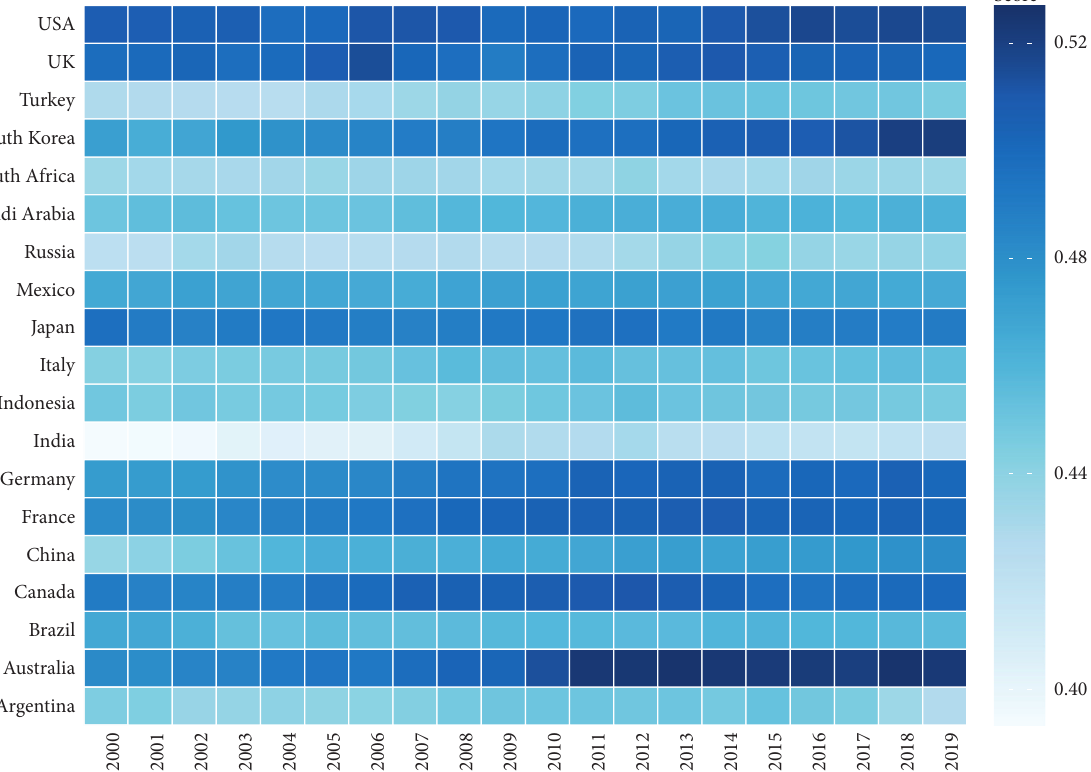
Figure 3: Scores of higher education development in 19 countries.